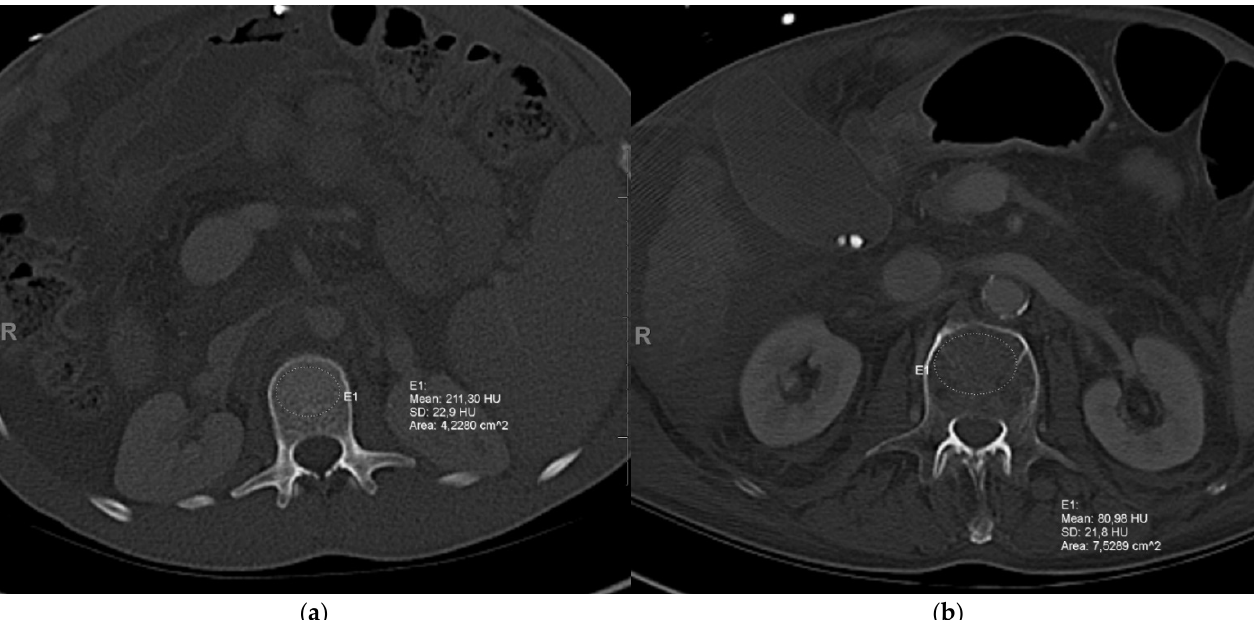
Figure 1. Assessment of bone mineral density (BMD) on routine CT scans. BMD was measured on routine CT scans upon ICU admission in the anterior portion of the trabecular space in the upper one-third of the L1. Two exemplary CT scans of patients with ( a ) high (221.3 HU) or ( b ) low BMD (80.98 HU) are shown.